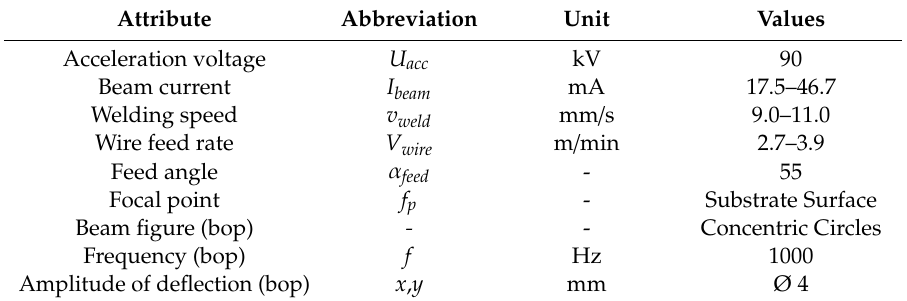
Table 2. Summary of input and beam oscillation (bop) parameters for welding and adjustment of wire feed unit.